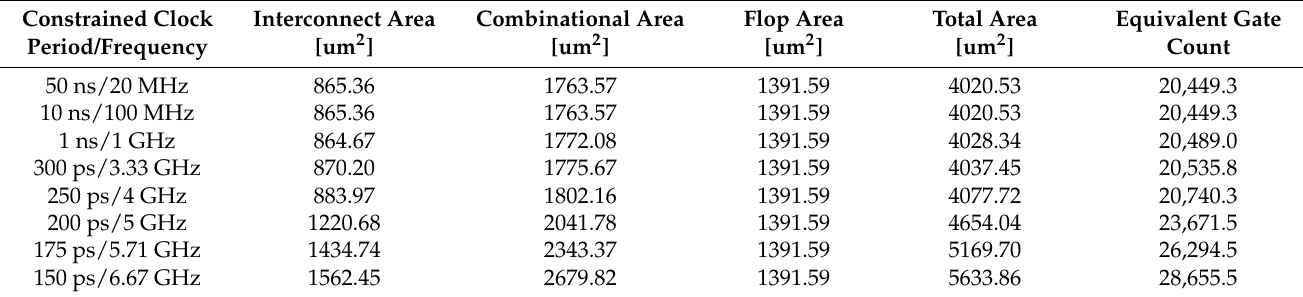
Table 5. Summary of the synthesis results (area) of the DST processing